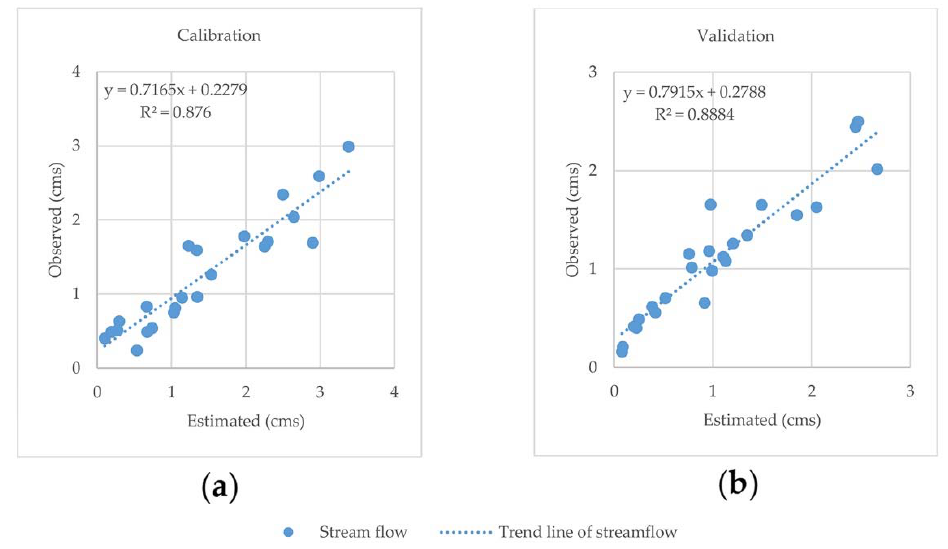
Figure 9. Scatter plot between observed and estimated streamflow at Khlong Bang Yai watershed under the dry year condition: ( a ) calibration period; ( b ) validation period.